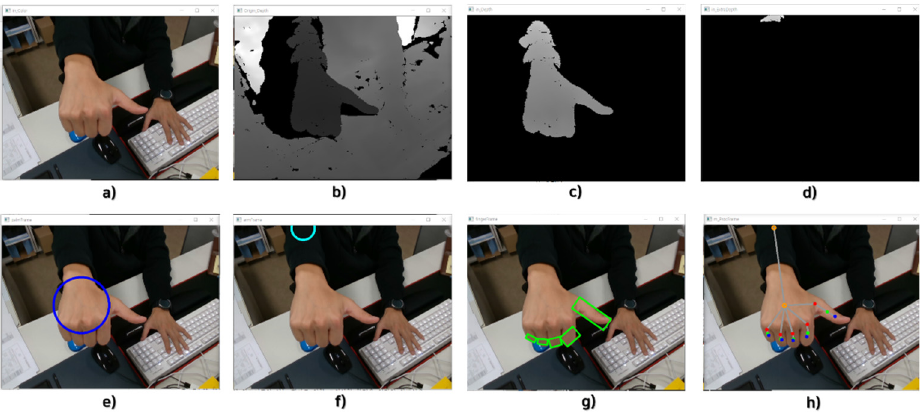
Figure 10. Gesture recognition algorithm detection process and results (Gesture Type 1).